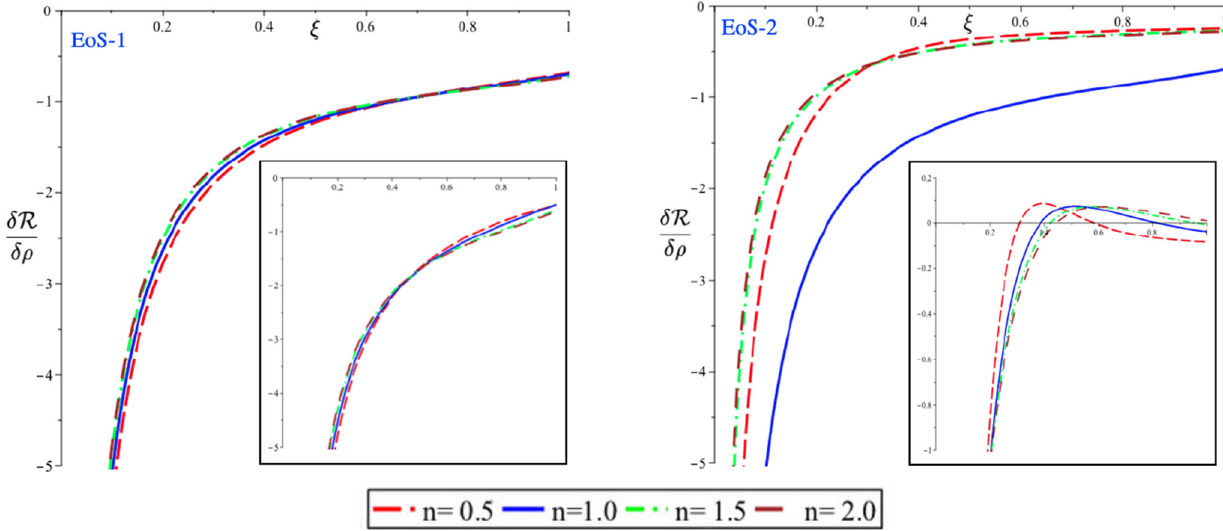
Fig. 7 The function δ R /δρ vs the dimensionless radius ξ = r / r b for a matter configuration with master anisotropic polytropic: EoS-1 (left) and EoS-2 (right) for different values of n and σ = 0 . 12. The same function is shown in the small insets but with the pressure gradient zero, i.e. δ R p = 0